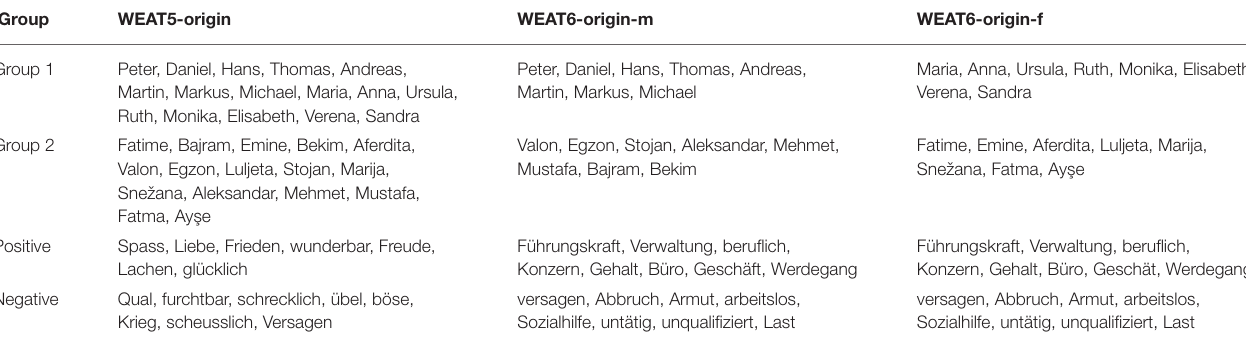
TABLE 6 | The terms from the new experiments investigating origin bias in Switzerland on German word embeddings.